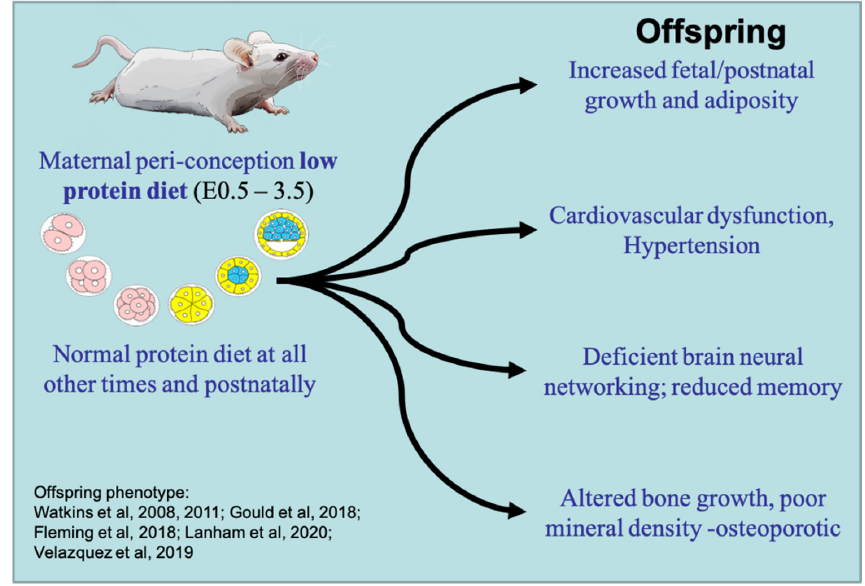
Figure 1. Diagrammatic representation of the maternal Emb-LPD mouse model. Maternal low protein diet is provided exclusively for the preimplantation period with normal nutrition, thereafter leading to co-morbidities affecting growth, cardiometabolic, neurological and skeletal health. Key references for these outcomes are identified, in sequence being 40, 42, 43, 1, 44, 2. See text for